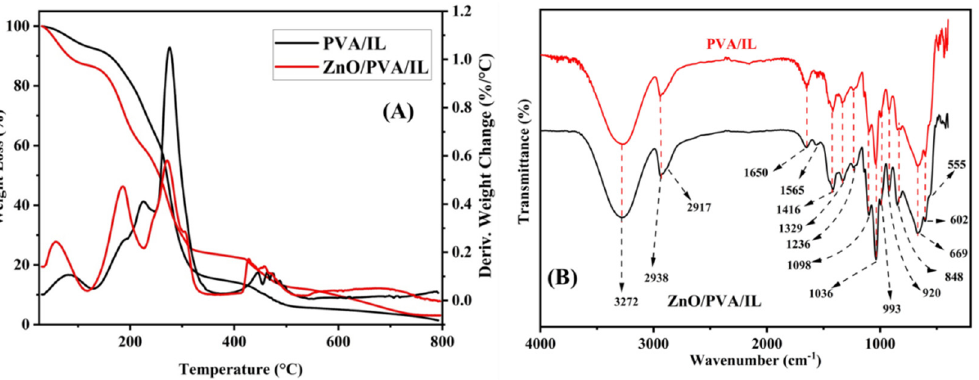
Figure 3. ( A ) TGA comparison of PVA/IL and ZnO/PVA/IL membranes. ( B ) FTIR spectra of PVA/IL and ZnO/PVA/IL membrane.